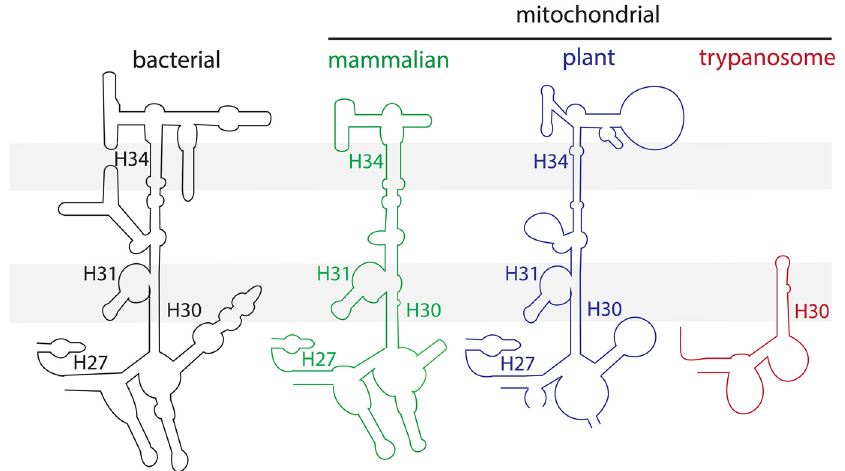
Fig 1. The ribosomal small subunit rRNA loops containing H31 and H34, as well as H27, double- stranded helices from bacteria (black) plus the mitochondria of mammals (green), plants (blue) and trypanosomes (red). Grey shading highlights the location of H31 and H34 in the SSU rRNAs bearing these motifs, as well as their absence in the same region of the trypanosomatid SSU rRNA. Helix H30, which is conserved throughout all the depicted rRNAs, is also indicated as a reference point. Adapted from [8] and [9].